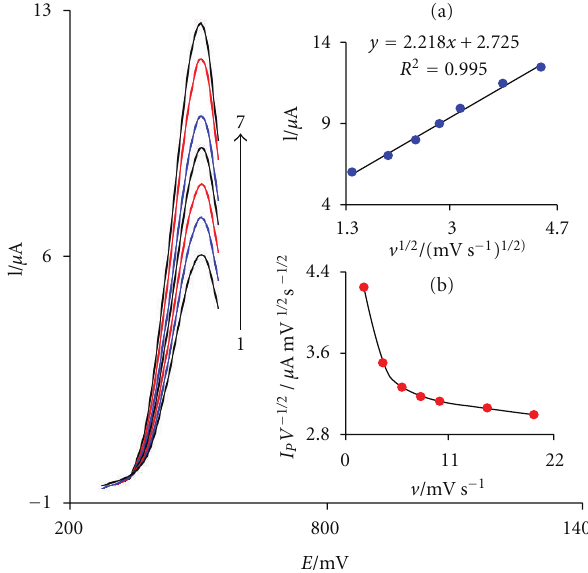
Figure 2: Linear sweep voltammograms of FCDCNPE in 0.1 M PBS (pH 5.0) containing 0.35 μ M CD at various scan rates; numbers 1–7 correspond to 2, 4, 6, 8, 10, 15, and 20 mVs − 1 , respectively. Insets: variation of (a) anodic peak current versus ν 1 / 2 ; (b) normalized current ( I p / ν 1 / 2 ) versus ν .